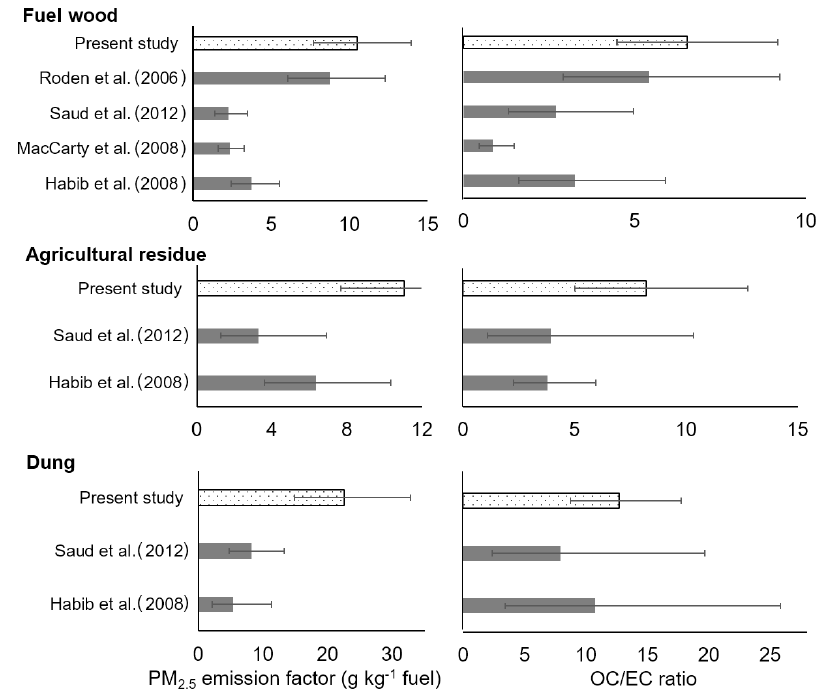
Figure 4. Average PM 2 . 5 emissions factors and OC / EC ratios for the three fuel categories in this study, compared with relevant studies. Error bars for values estimated in this study denote 95% confidence intervals based on standard errors of the means. Error bars for other studies are the bounds reported within those